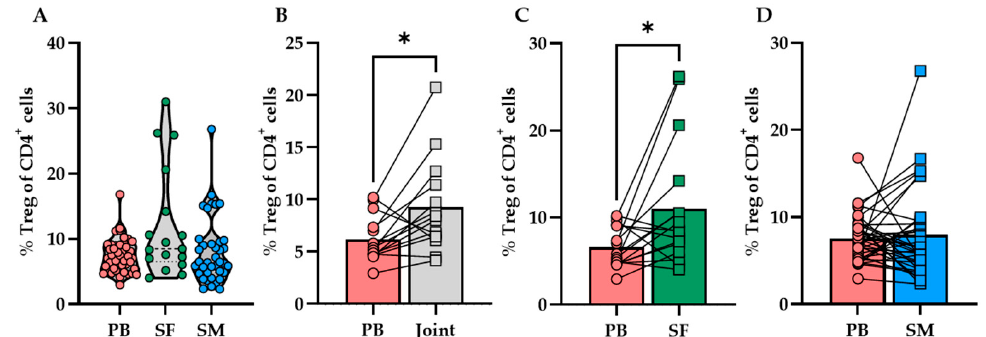
Figure 2. Regulatory T-cell (Treg) infiltration profile in OA joints and peripheral blood. ( A ) Overview of the mean Treg proportions (% Treg of CD4 + cells) in peripheral blood (PB), synovial fluid (SF) and synovial membrane (SM). ( B – D ) Matched-pairs analysis comparing mean Treg proportions in PB with the mean Treg proportions in ( B ) joint-derived samples (SF and SM), ( C ) SF and ( C ) SM alone. ( A ) Comparing the mean Treg proportions (% Treg of CD4 + cells) in peripheral blood (PB), synovial fluid (SF) and synovial membrane (SM) did not show significant differences between tissue types (Kruskal–Wallis test, p = 0.1636). ( B – D ) However, matched-pairs analysis demonstrated ( B ) significantly higher Treg proportions in joint-derived samples (SF and SM) than in PB (Wilcoxon matched-pairs signed rank test, p = 0.0203, n = 14), which can be mainly attributed to ( C ) high infiltration rates of Tregs in SF (Wilcoxon matched-pairs signed rank test, p = 0.0250, n = 16) rather than ( D ) the Treg proportions in SM (Wilcoxon matched-pairs signed rank test, p = 0.8907, n = 35). p -Values < 0.05 were considered statistically significant and are indicated with asterisks: * p < 0.05.